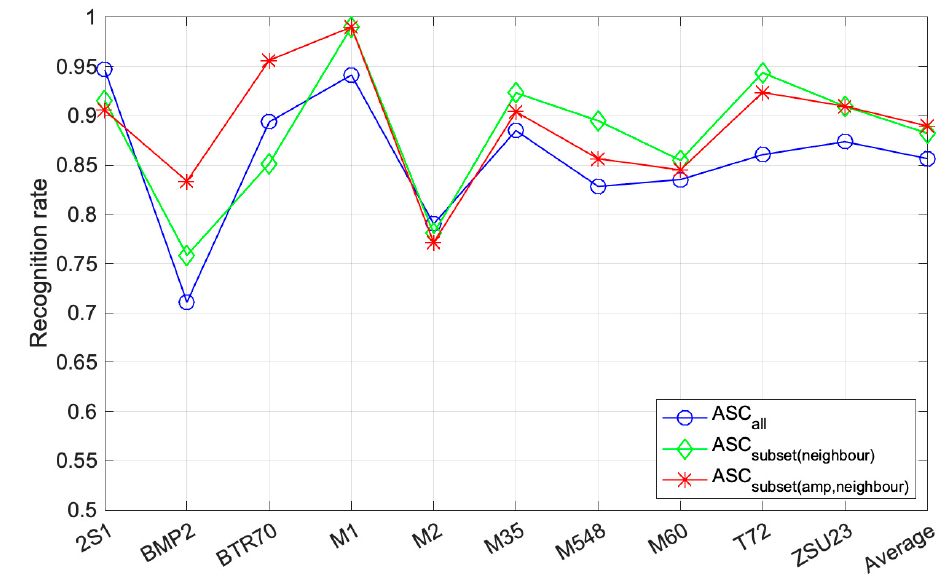
Figure 10. Recognition rate of each target according to different sets of scattering centers.